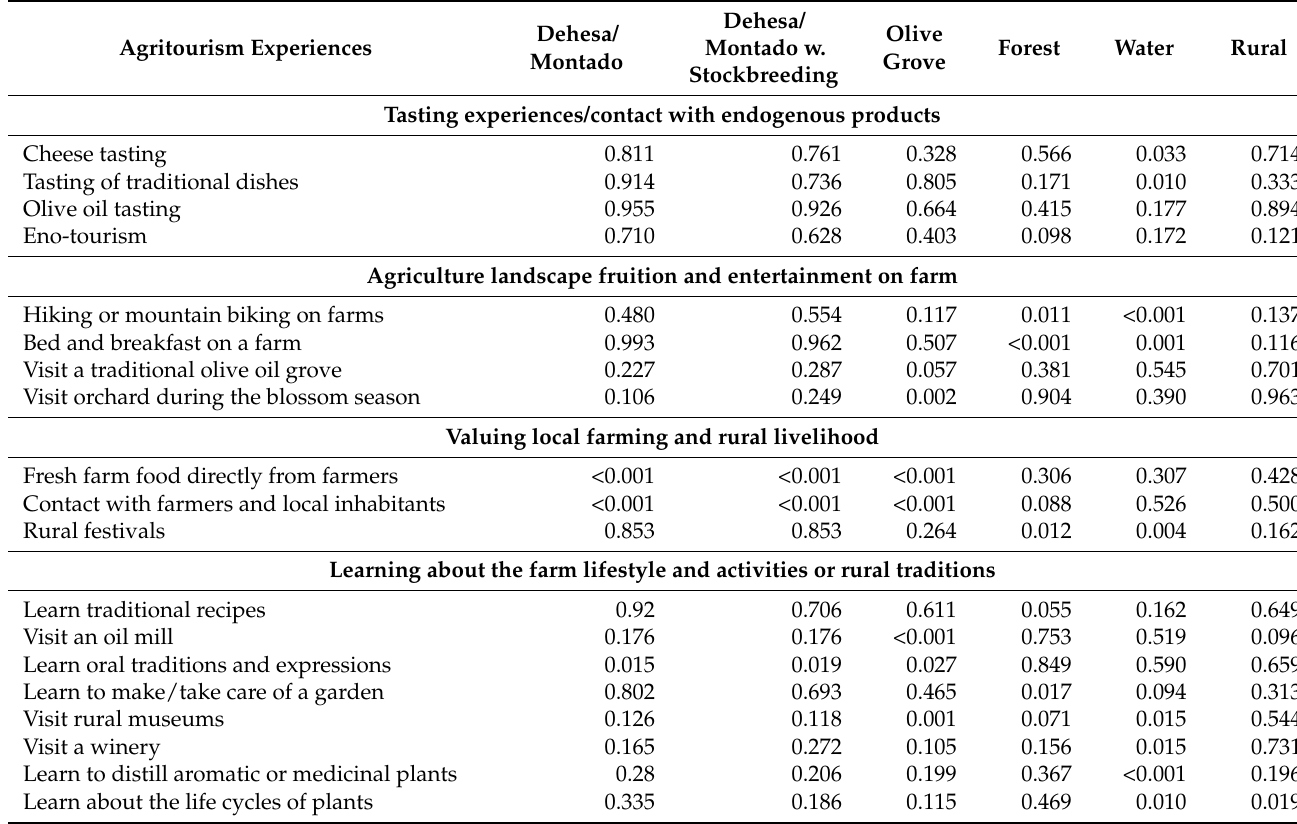
Table A3. Chi-Square Test between Agritourism Experiences and Landscape